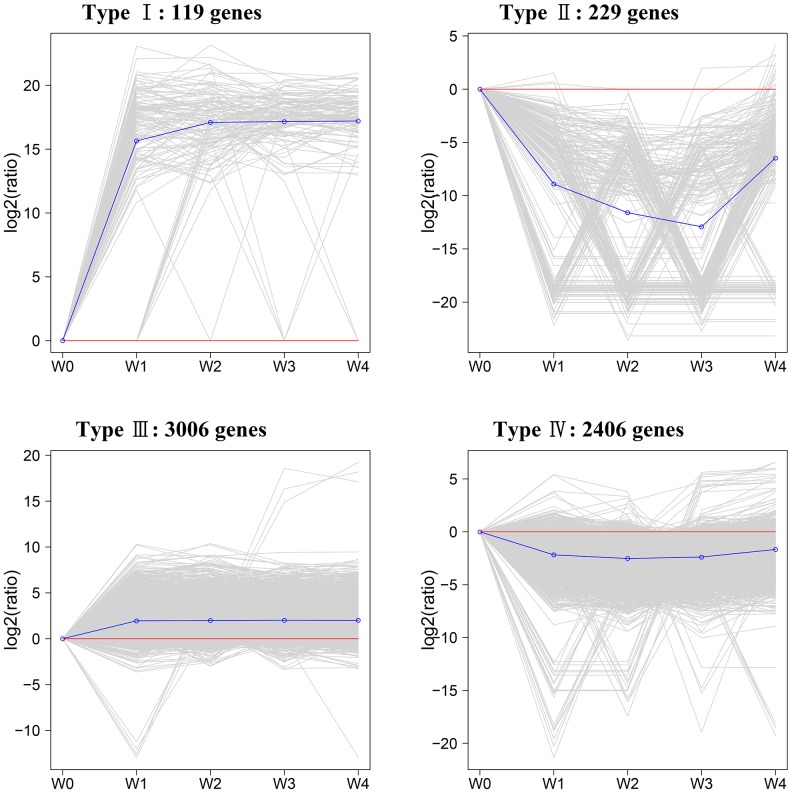
Differentially expressed genes during in vitro organogenesis were clustered by the k-Means method, which is based on their expression modulation.The relative expression level was obtained after taking equation and logarithmic transformations of RPKM.